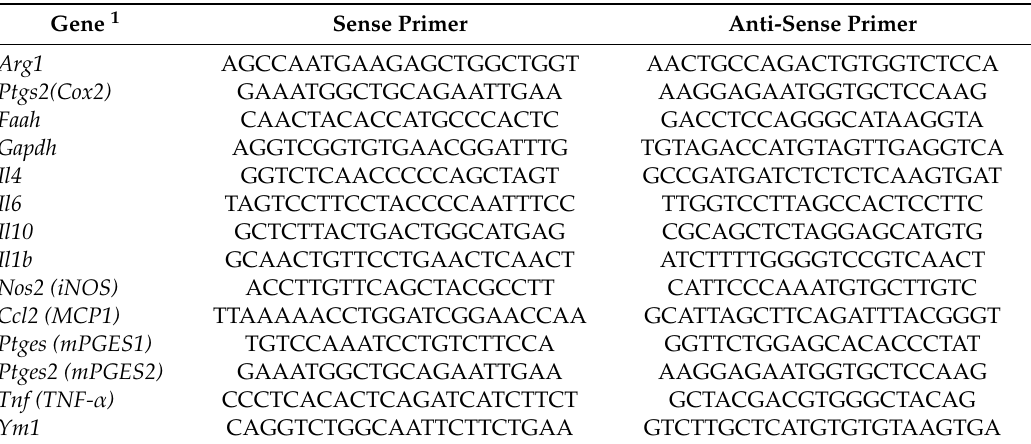
Table 1. Primer sequences for